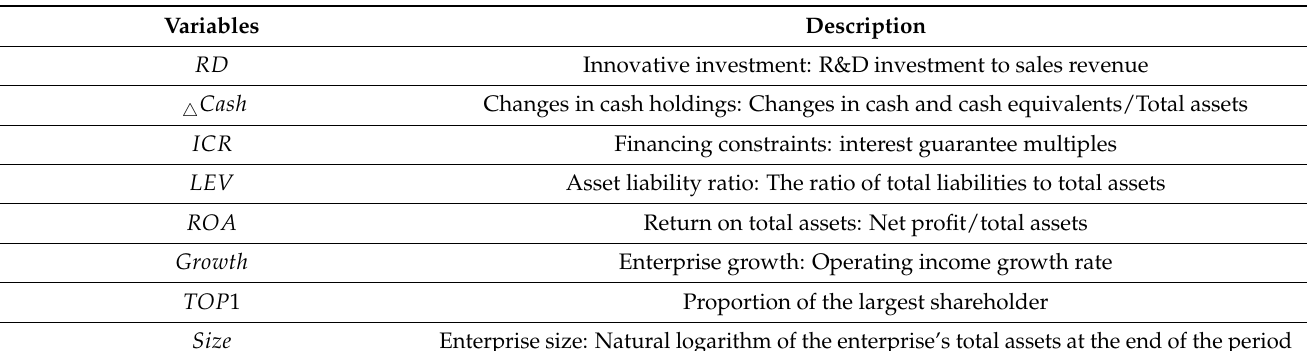
Table 1. Definition and description of main